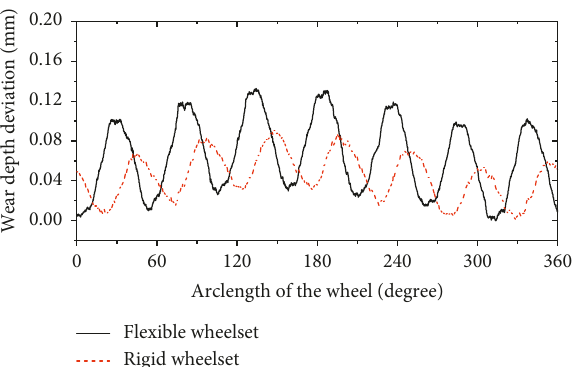
Figure 20: Simulated wear depth deviation after 25 iteration steps (13,750km) with and without wheelset flexibility